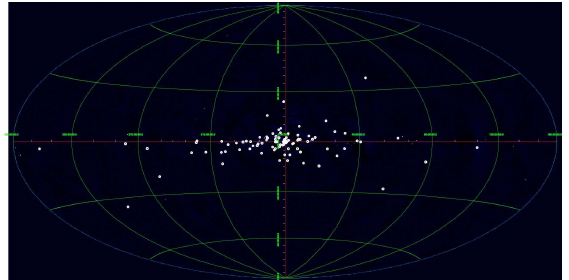
Figure 2: Distribution of LMXBs (white filled circles) in the 20-100 keV sky imaged by IBIS. They are segre- gated in the Galactic bulge and in Globular Clusters.